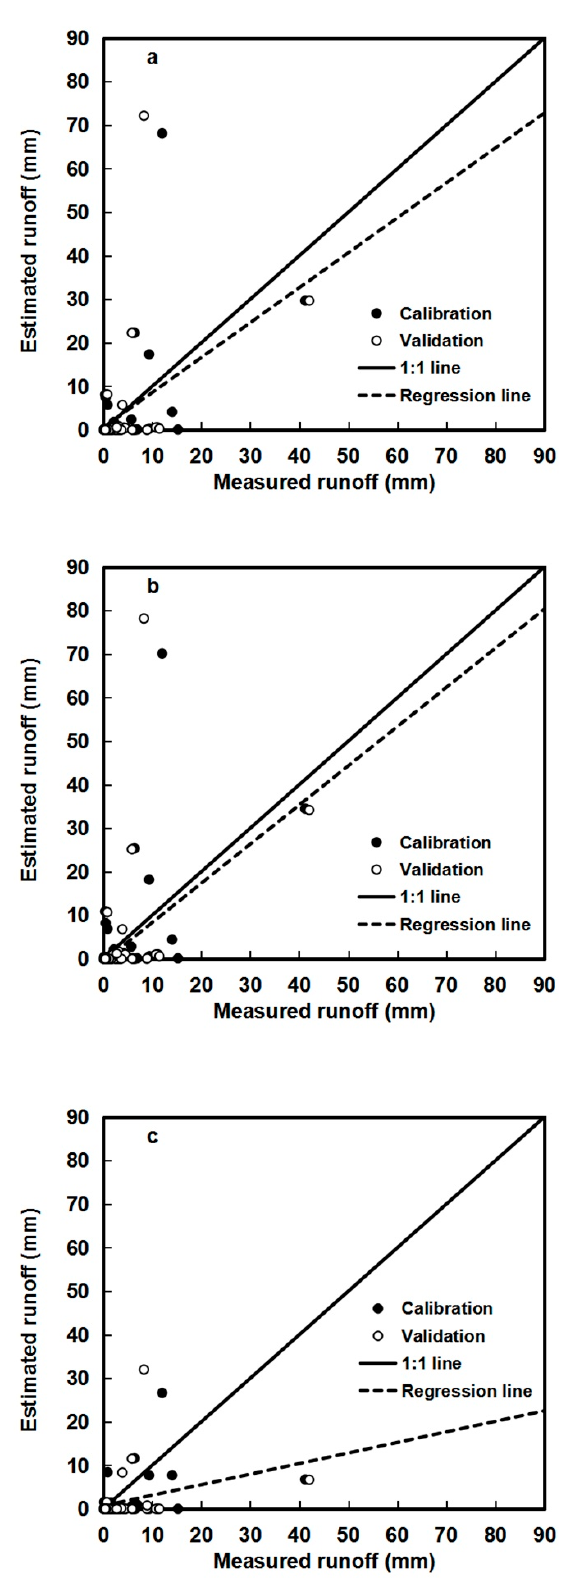
Figure 4. Measured versus estimated runoff depths for ( a ) the original Soil Conservation Service Curve Number (SCS-CN) method, ( b ) Huang et al. [15] method, and ( c ) Huang et al. [34] method for the calibration and validation of the three runoff plots located in the XDG watersheds.